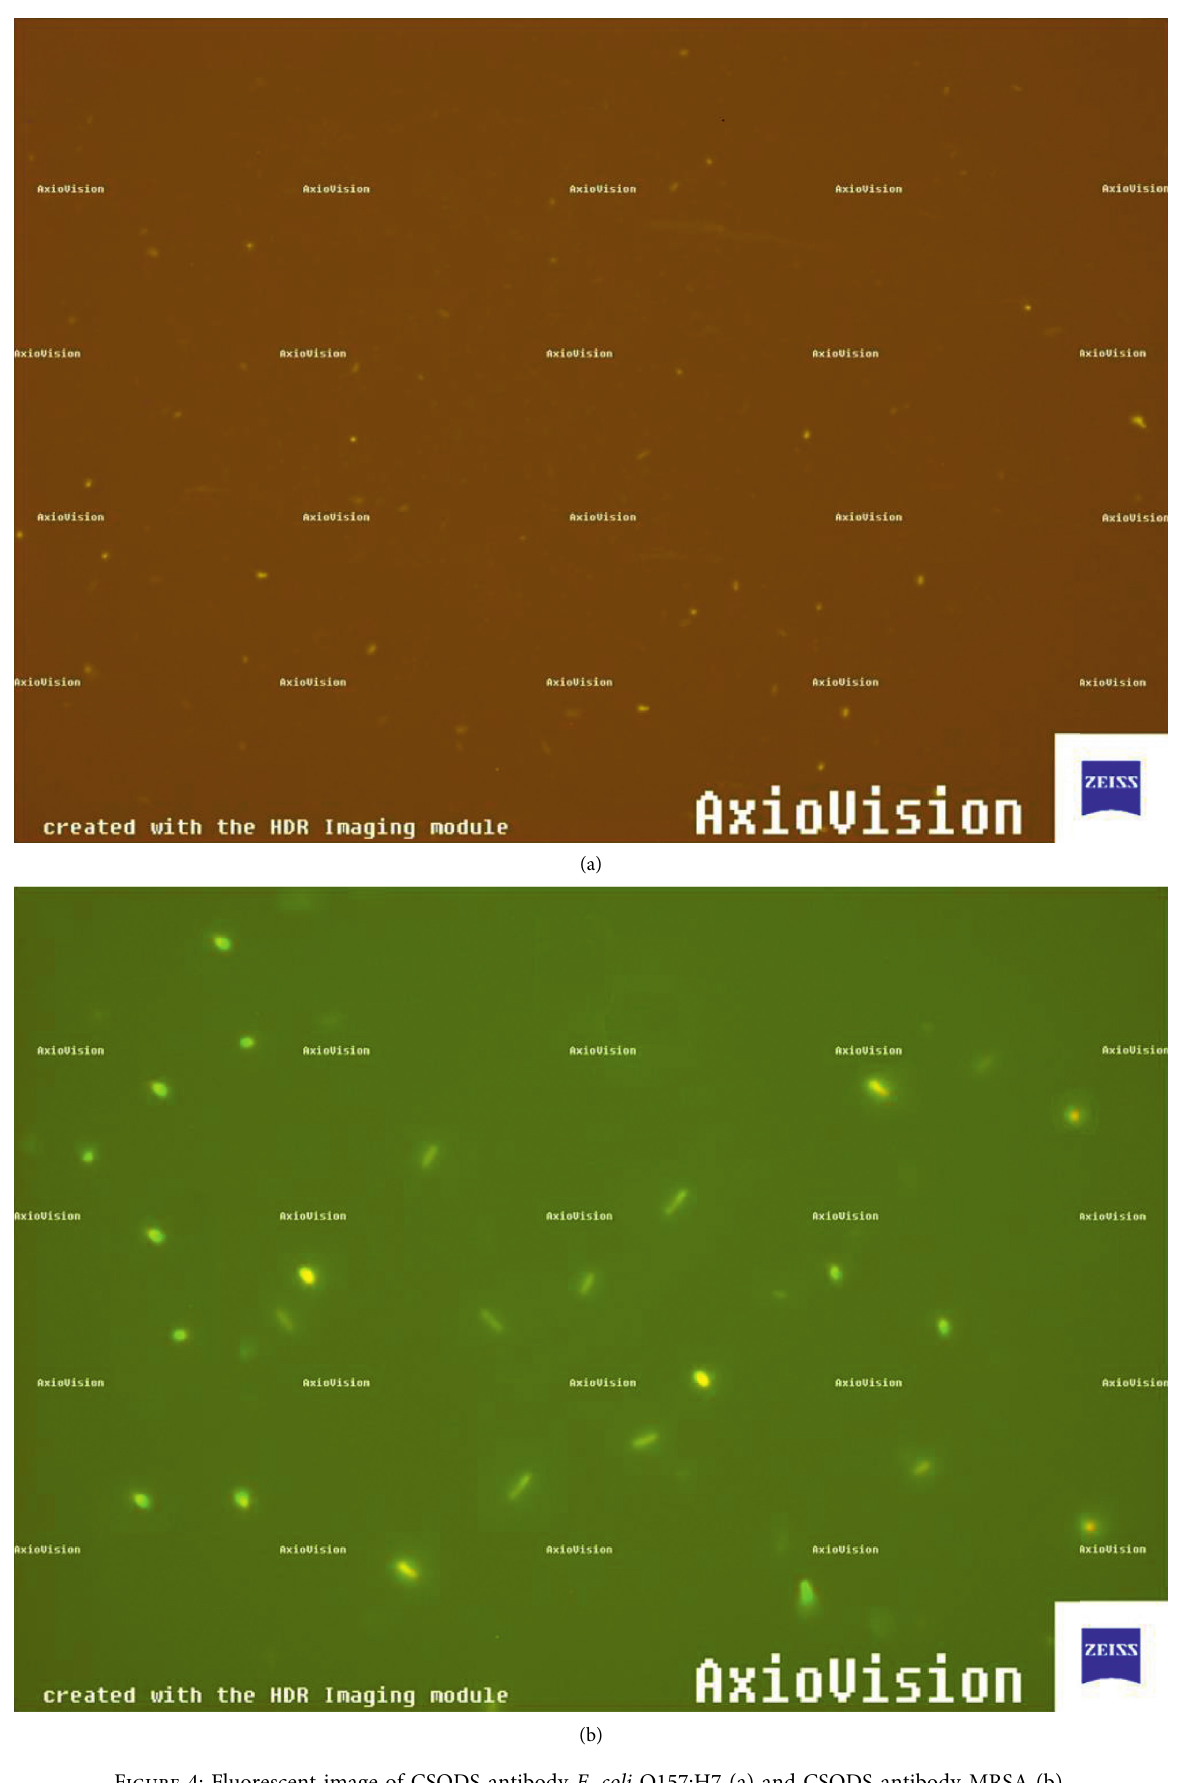
Figure 4: Fluorescent image of CSQDS-antibody- E. coli O157:H7 (a) and CSQDS-antibody-MRSA